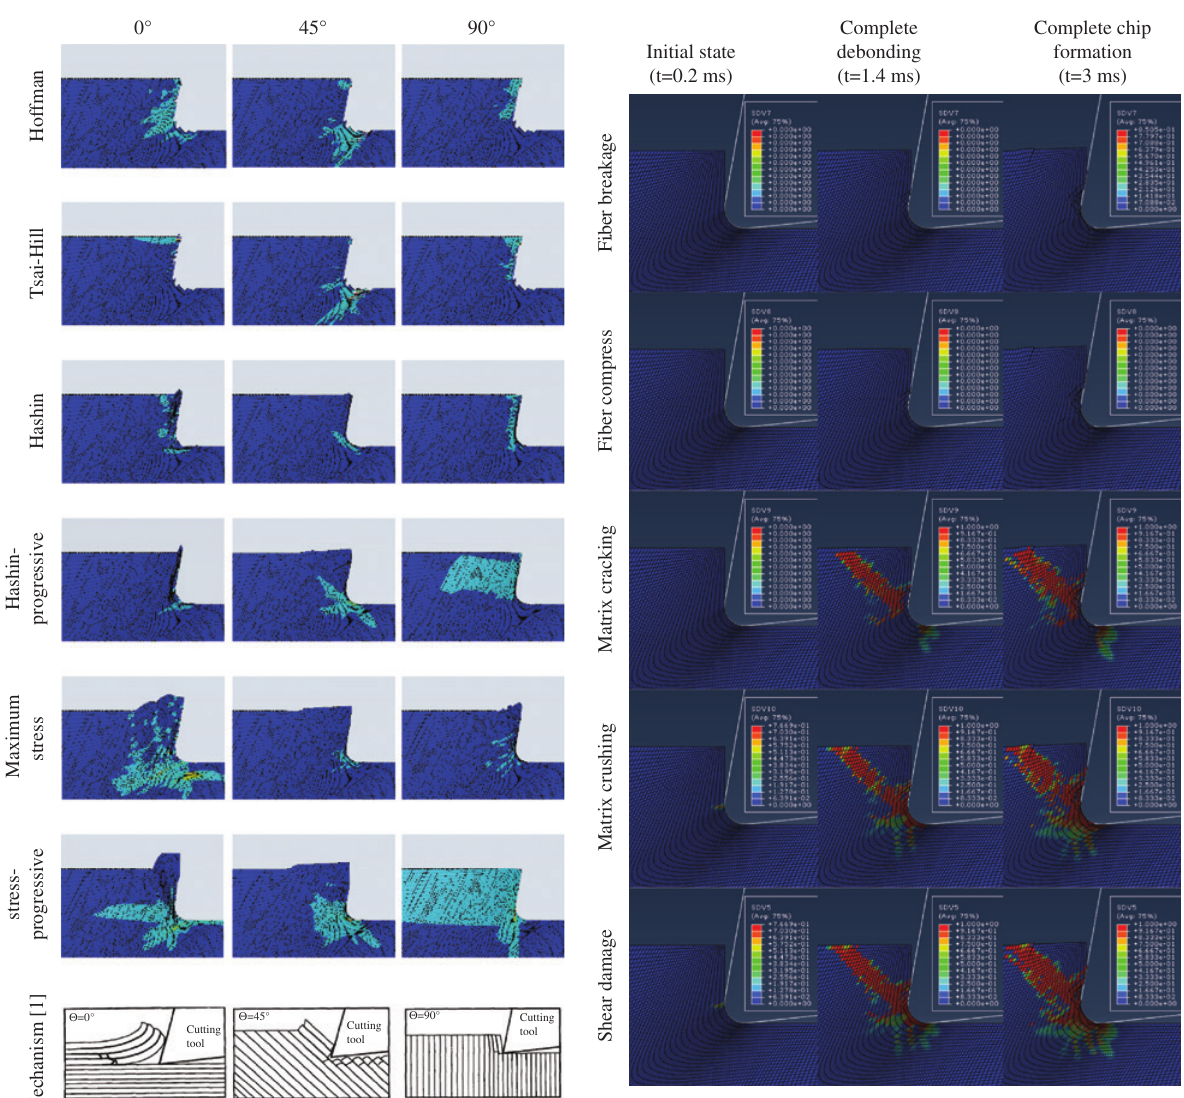
Figure 5: Damages during chip formation for Hashin-progressive damage (fiber orientation 45 °